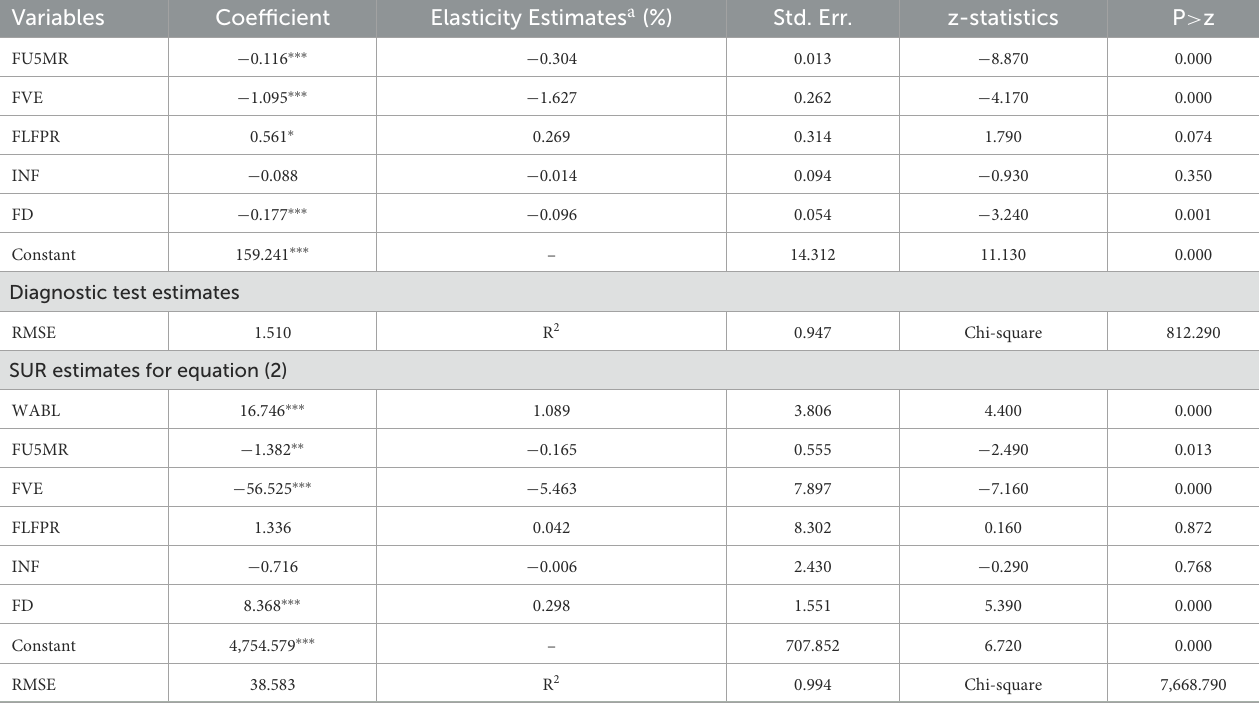
TABLE 2 SUR estimates for equations (1) and (2). Variables